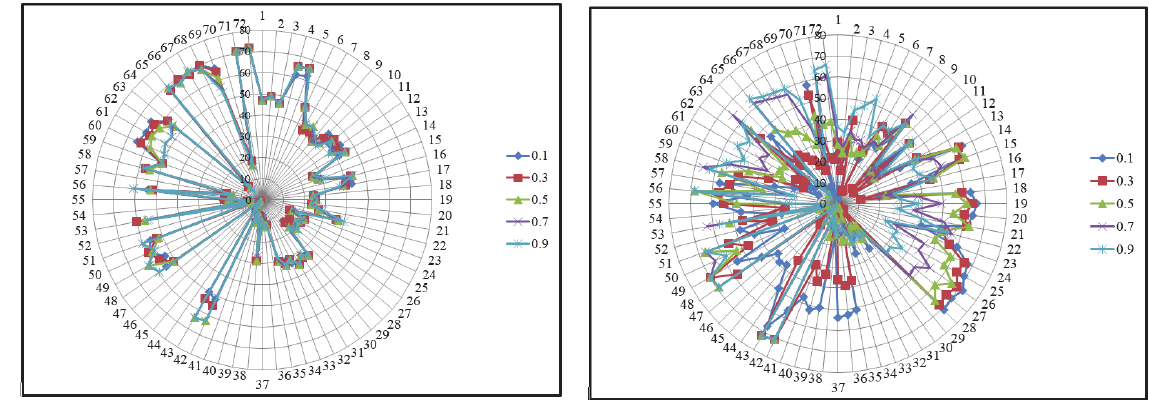
Fig. 5. Ranking of alternatives for different maximum group utility coefficients